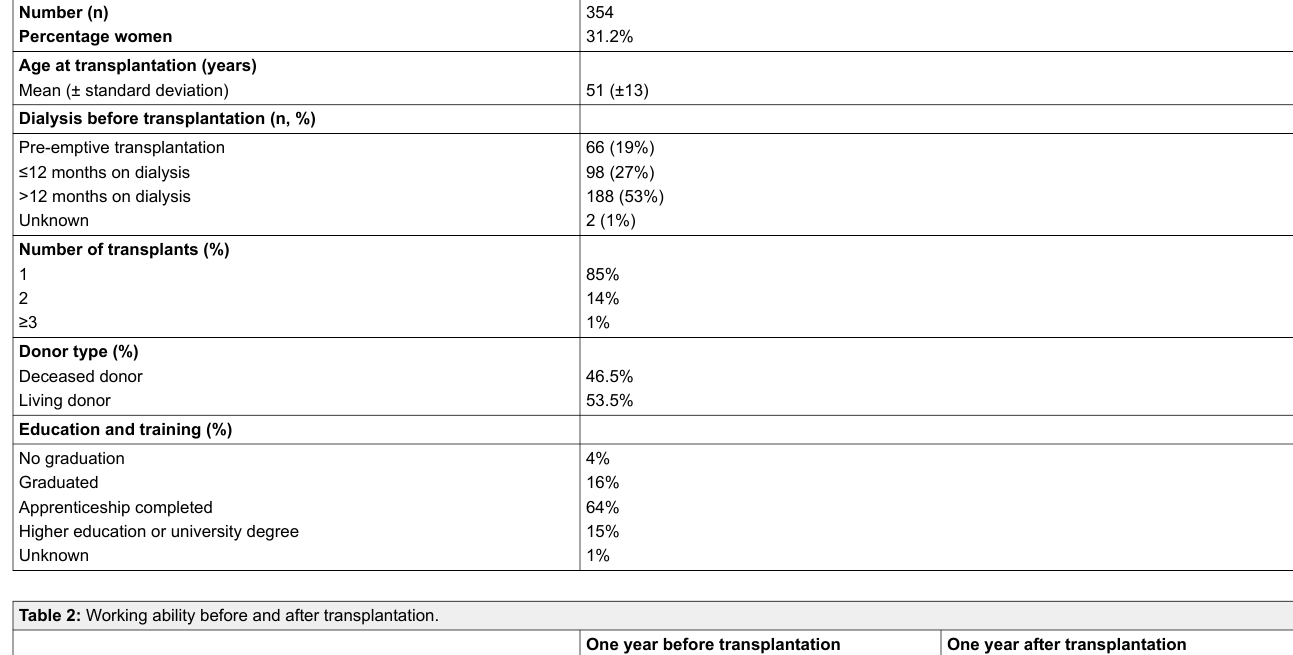
Table 1: Baseline data of respondents.